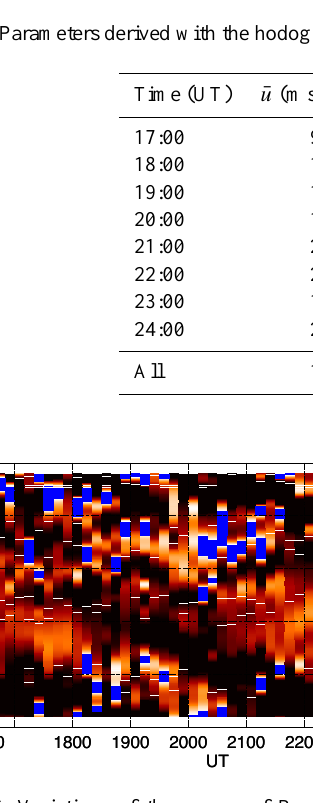
Figure 6. Variations of the square of Brunt–Väisälä frequencies ( N 2 ) from 16:30 to 24:30UT between 81 and 104km. Negative N 2 regions are shown by blue filled squares.